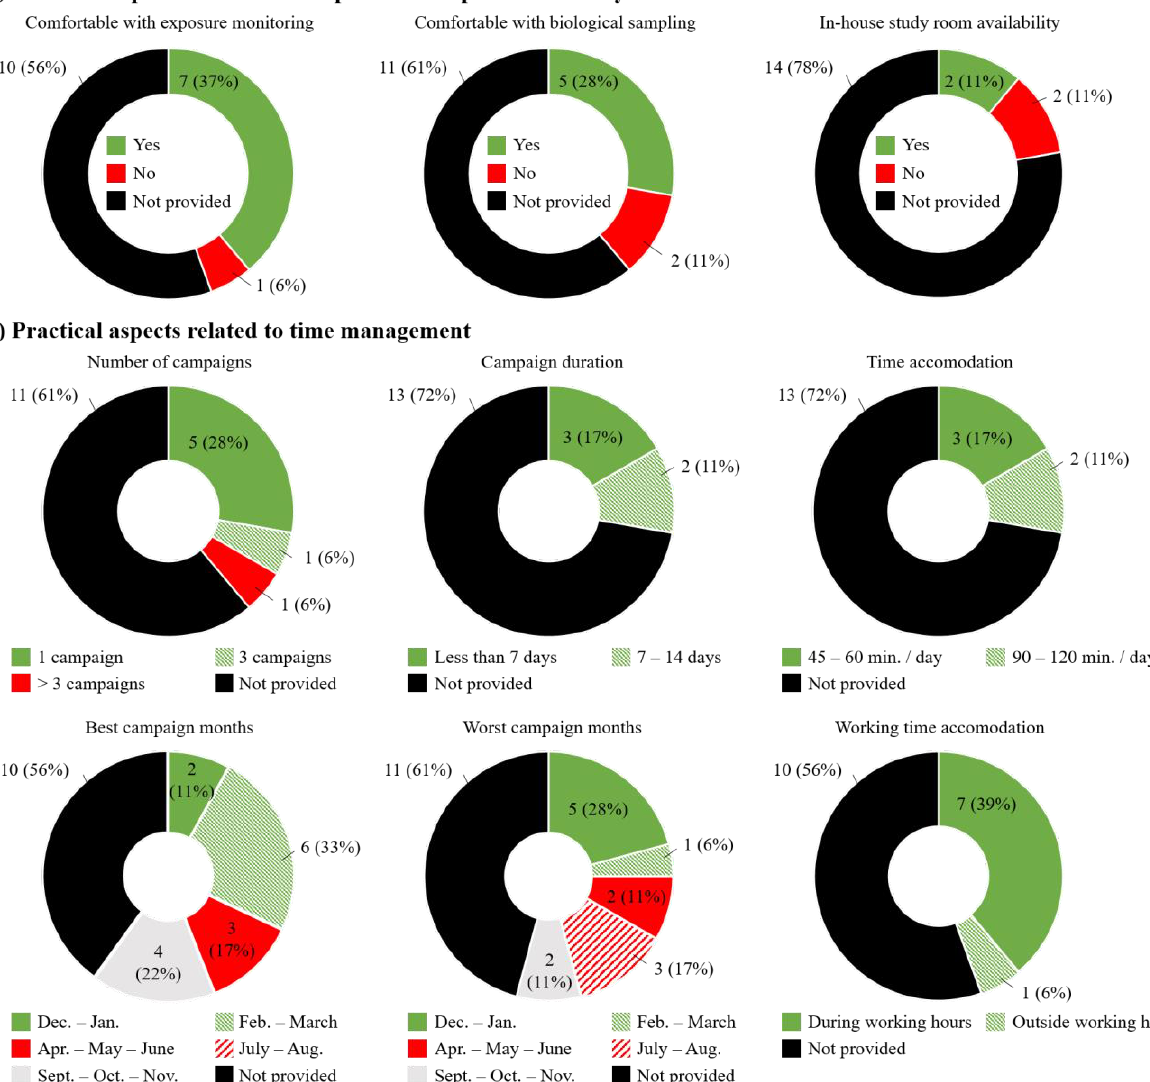
Figure 5. Managers’ responses regarding the feasibility of a research study and practical aspects associated with: ( A ) acceptance and space availability and ( B ) time management.